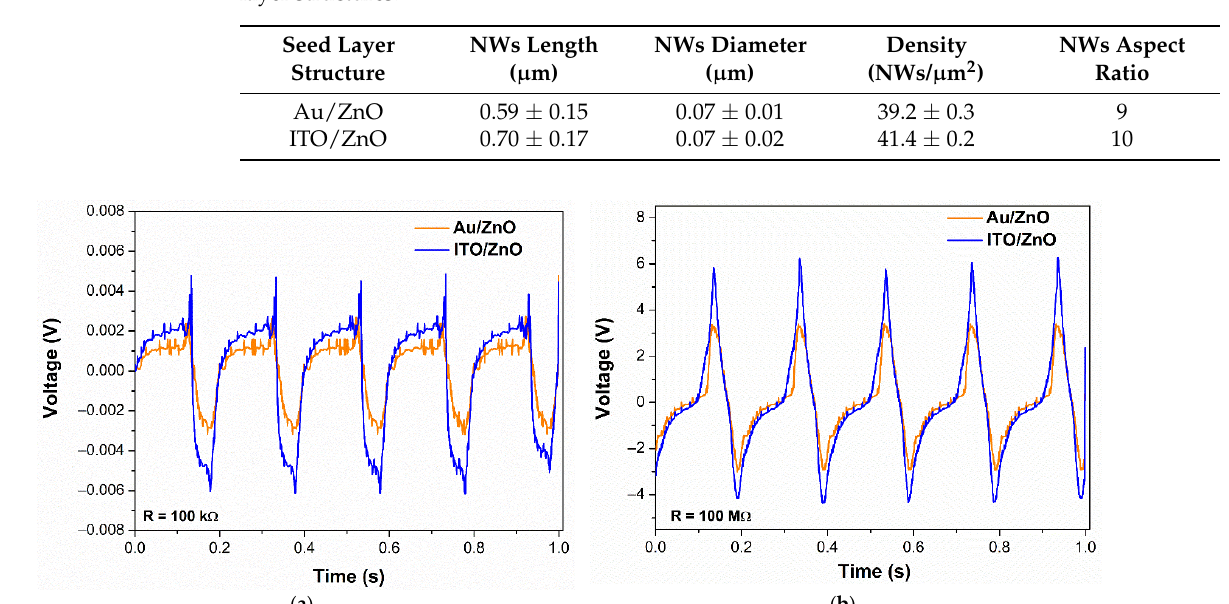
Figure 8 . Voltage amplitude of the fabricated PENGs with different seed layer structures at a load resistance of ( a ) 100 kΩ Figure 8. Voltage amplitude of the fabricated PENGs with different seed layer structures at a load resistance of ( a ) 100 k Ω and ( b ) 100 MΩ, when applying an alternative mechanical excitation with a magnitude of 3 N at a frequency of 5 Hz. and ( b ) 100 M Ω , when applying an alternative mechanical excitation with a magnitude of 3 N at a frequency of 5